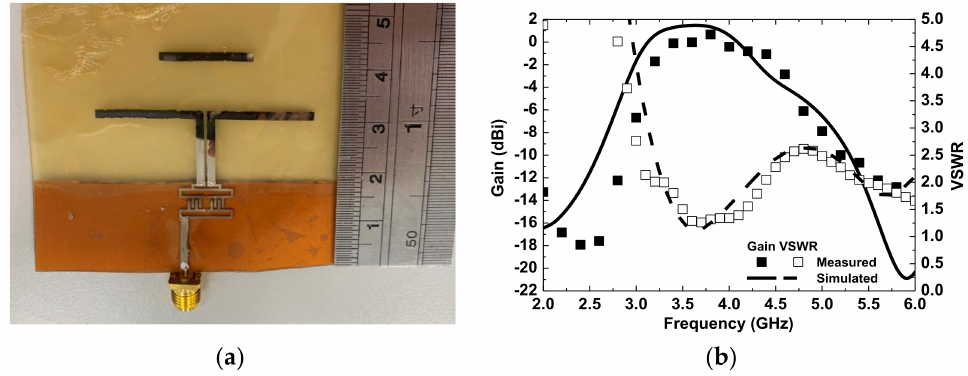
Figure 13. ( a ) Photo and ( b ) simulated and measured input VSWR and gain of the filtering antenna.